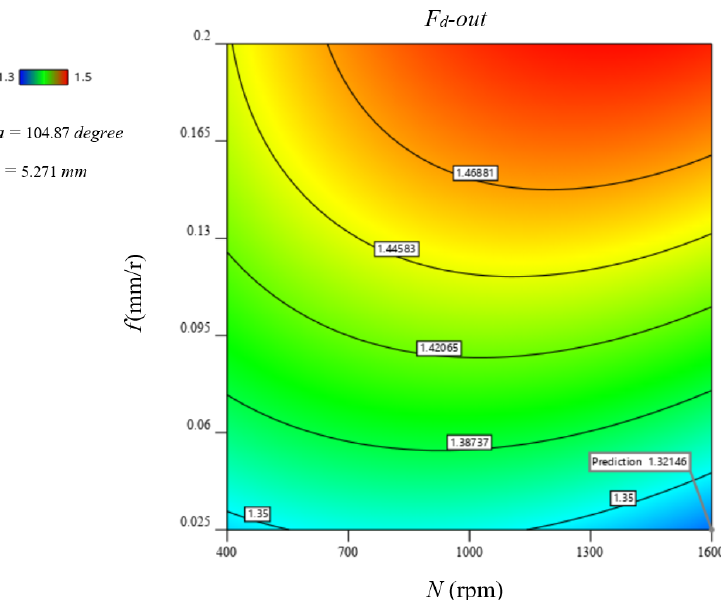
Figure 13. Contour plot of delamination − exit ratio at optimal parameters N = 1600 rpm and f = 0.025 mm/r.